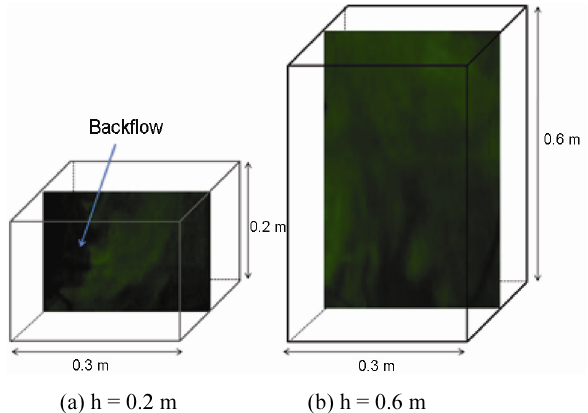
Fig. 3. Smoke flow configuration in the vertical center section of the